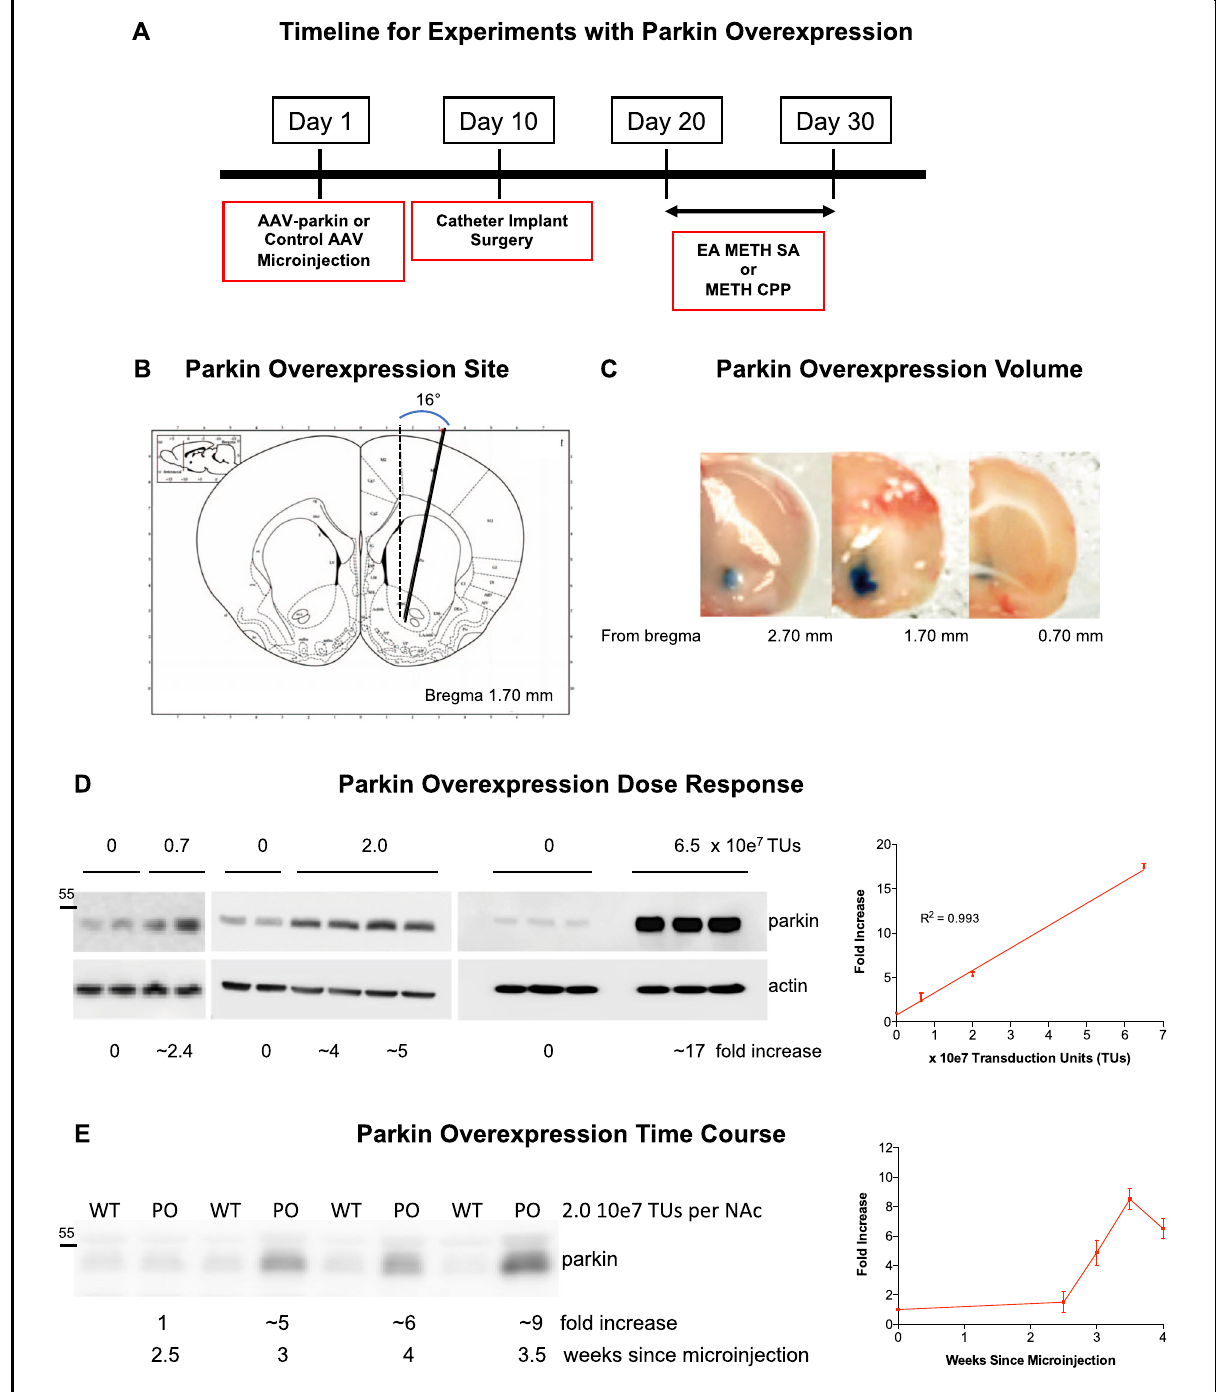
Fig. 1 Validation of PARKIN overexpression. A Timeline for experiments with PARKIN overexpression. B , C Validation of the overexpression site (nucleus accumbens, 0.7 – 2.7 mm from bregma) and spread (medial-lateral, dorsal-ventral, and anterior-posterior). D Dose – response of PARKIN overexpression (0, 0.7, 2, or 6.5 × 10 7 TUs/side) in the nucleus accumbens ( n = 3 or 4/group). The data followed a linear regression curve ( R 2 = 0.993, p < 0.0001). E Time course of PARKIN overexpression (2 × 10 7 TUs/side) showing that PARKIN overexpression reached the maximum at around 3.5 weeks after the gene transfer vector microinjection and excess of PARKIN persisted at least for the duration of the study (~4 weeks) ( D ). Parkin band migrated to ~52 kDa (relate to the marked molecular weight of 55 kDa). Parkin band was the only band detected; a representative full blot is presented in Fig.